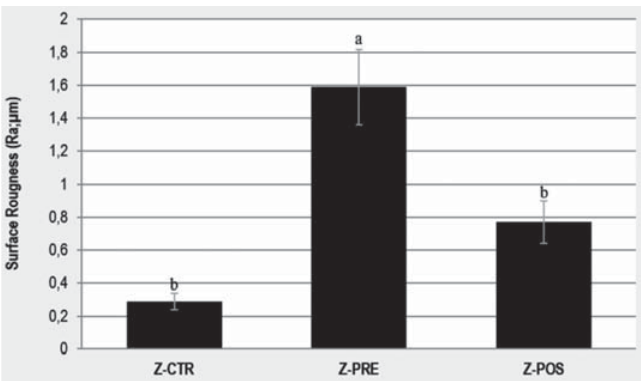
Figure 7- (cid:3)(cid:54)(cid:88)(cid:85)(cid:73)(cid:68)(cid:70)(cid:72)(cid:3)(cid:85)(cid:82)(cid:88)(cid:74)(cid:75)(cid:81)(cid:72)(cid:86)(cid:86)(cid:3)(cid:68)(cid:73)(cid:87)(cid:72)(cid:85)(cid:3)(cid:86)(cid:88)(cid:85)(cid:73)(cid:68)(cid:70)(cid:72)(cid:3)(cid:87)(cid:85)(cid:72)(cid:68)(cid:87)(cid:80)(cid:72)(cid:81)(cid:87)(cid:17)(cid:3)(cid:57)(cid:72)(cid:85)(cid:87)(cid:76)(cid:70)(cid:68)(cid:79)(cid:3)(cid:69)(cid:68)(cid:85)(cid:86)(cid:3)(cid:76)(cid:81)(cid:71)(cid:76)(cid:70)(cid:68)(cid:87)(cid:72)(cid:3)(cid:86)(cid:87)(cid:68)(cid:81)(cid:71)(cid:68)(cid:85)(cid:71)(cid:3)(cid:71)(cid:72)(cid:89)(cid:76)(cid:68)(cid:87)(cid:76)(cid:82)(cid:81)(cid:3)(cid:68)(cid:81)(cid:71)(cid:3)(cid:86)(cid:76)(cid:80)(cid:76)(cid:79)(cid:68)(cid:85)(cid:3)(cid:79)(cid:72)(cid:87)(cid:87)(cid:72)(cid:85)(cid:86)(cid:3)(cid:76)(cid:81)(cid:71)(cid:76)(cid:70)(cid:68)(cid:87)(cid:72)(cid:3)(cid:81)(cid:82)(cid:81)(cid:16)(cid:86)(cid:76)(cid:74)(cid:81)(cid:76)(cid:191)(cid:70)(cid:68)(cid:81)(cid:87)(cid:3) (cid:71)(cid:76)(cid:73)(cid:73)(cid:72)(cid:85)(cid:72)(cid:81)(cid:70)(cid:72)(cid:86)(cid:3)(cid:11)(cid:83)(cid:33)(cid:19)(cid:17)(cid:19)(cid:24)(cid:12)